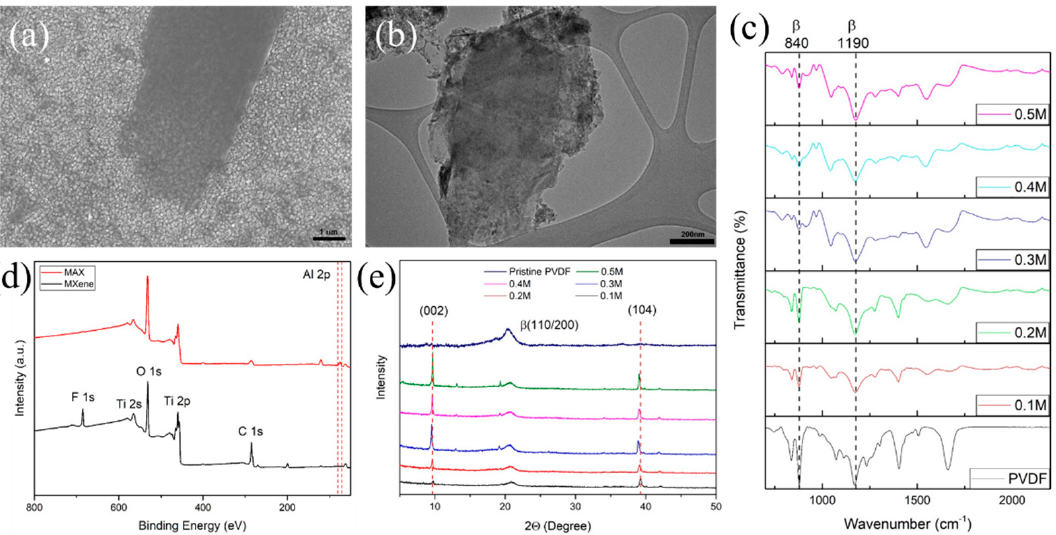
Figure 2. ( a ) FESEM images of Ti 3 C 2 T x nanosheets ( b )TEM images of Ti 3 C 2 T x nanosheets ( c ) FTIR spectrum of various FeCl 3 concentration ( d ) XPS spectrum of MAX phase and Ti 3 C 2 T x nanosheets ( e ) XRD spectrum of electrospun PVDF and various FeCl 3 concentration.